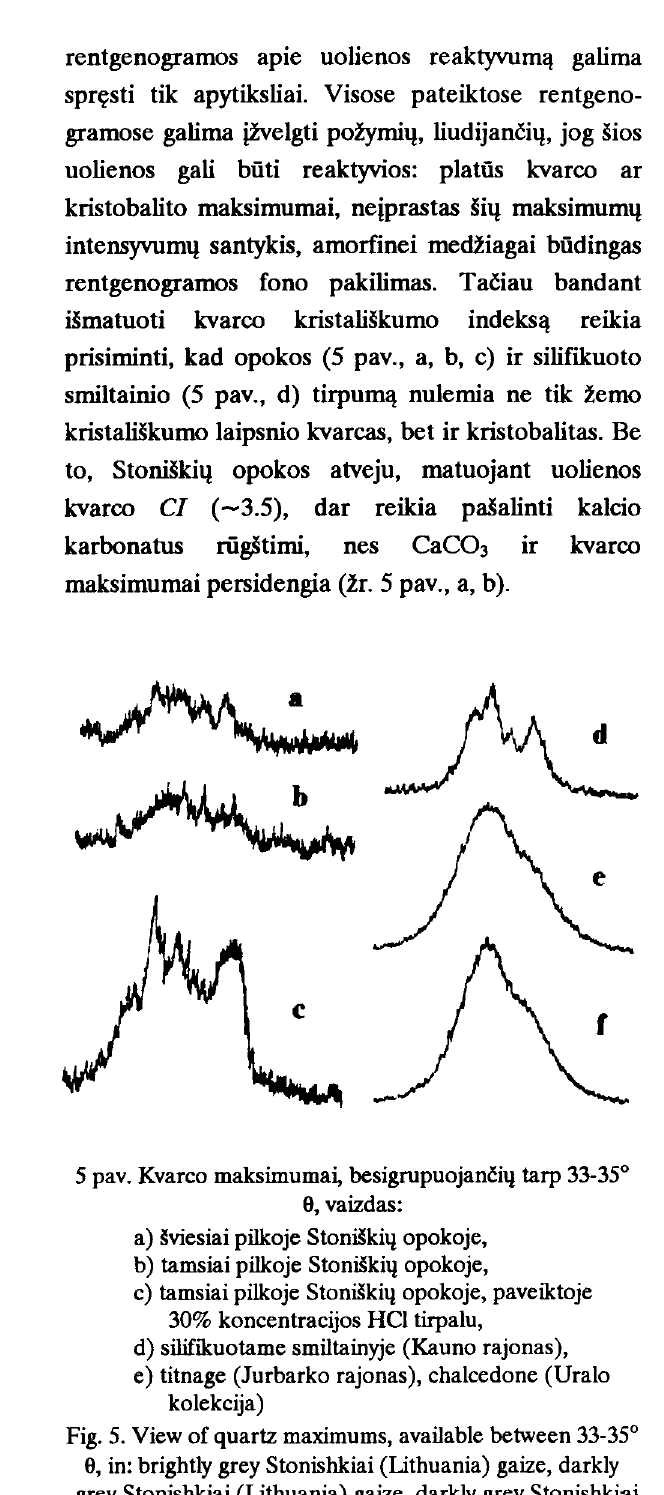
Fig. 5. View of quartz maximums, available between 33-35° 9, in: brightly grey Stonishkiai (Lithuania) gaize, darkly grey Stonishkiai (Lithuania) gaize, darkly grey Stonishkiai (Lithuania) gaize, effected by 30% HCI, chert from Kaunas region (Lithuania), flint from Jurbarkas region (Lithuania), chalcedony from Ural mountains (collection) Silifikuotame smiltainyje C/==3,57, o Jurbarko titnage ir chalcedone CI galima laikyti mafesniu uZ vienetlt, nes nepavyko isskirti maksimumo d=1,38204 A (5